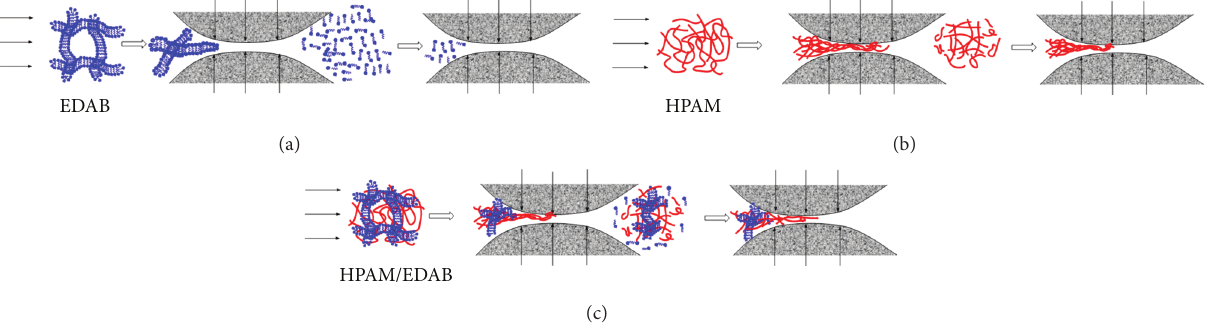
Figure 5: Schematic description of the chemical flooding processes for the samples: (a) EDAB, (b) HPAM, and (c) HPAM/EDAB